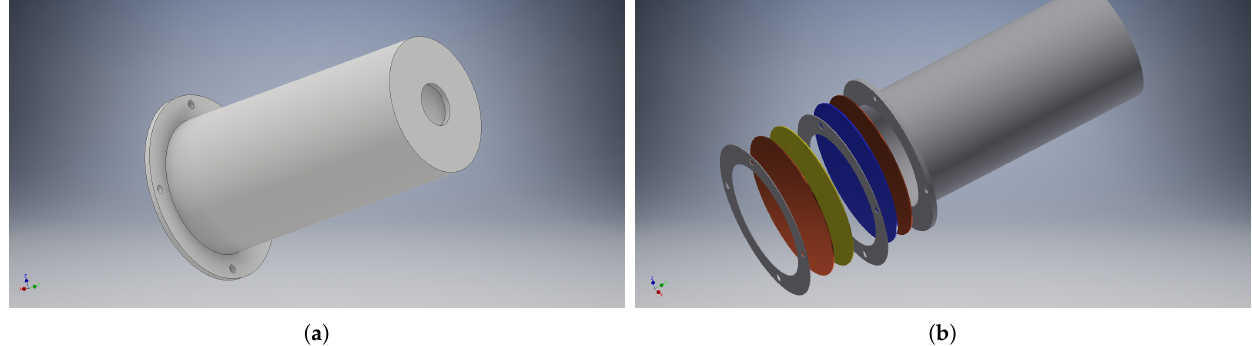
Figure 5. Neck-less Helmholtz resonator ( a ). Three-dimensional structure with dielectric and electrode layers and spacers ( b